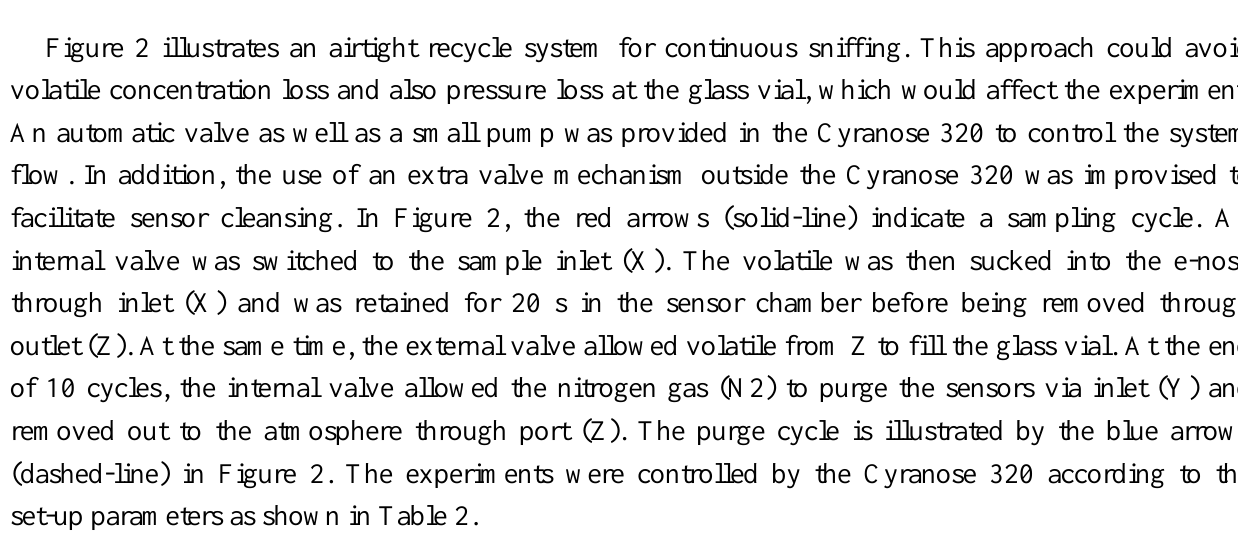
Figure 2. Experimental setup for the classification of agarwood oil.